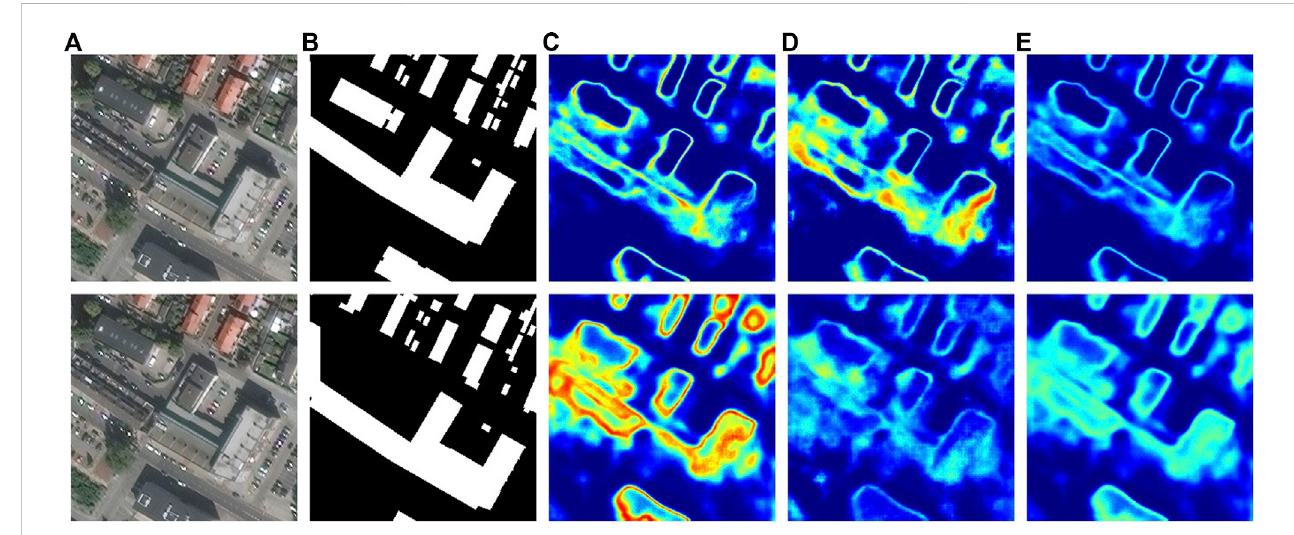
FIGURE 3 Heatmaps of predictive uncertainty during training with 0% omission noise in the top row and 20% omission noise in the bottom row at epoch 15. (A) Satellite image (B) training label (C) average softmax of predicted class (D) standard deviation (E) Var al . All uncertainty values are scaled for better